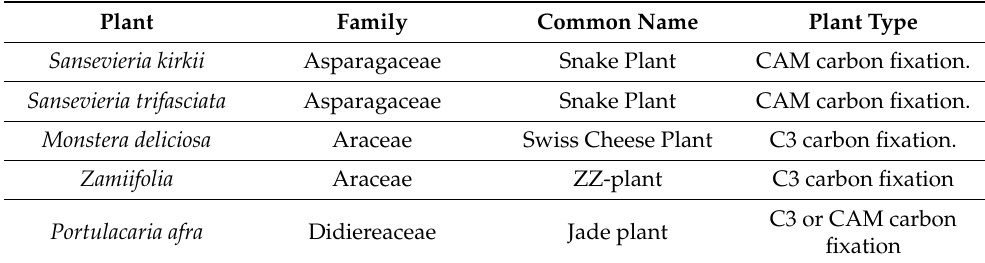
Table 2. Details about selected Plant species.